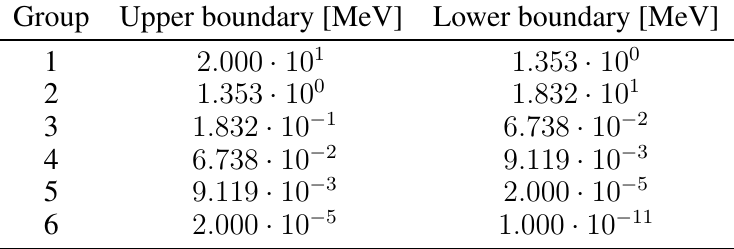
Table 1: Six-group data adopted to perform the macroscopic cross section energy collapsing